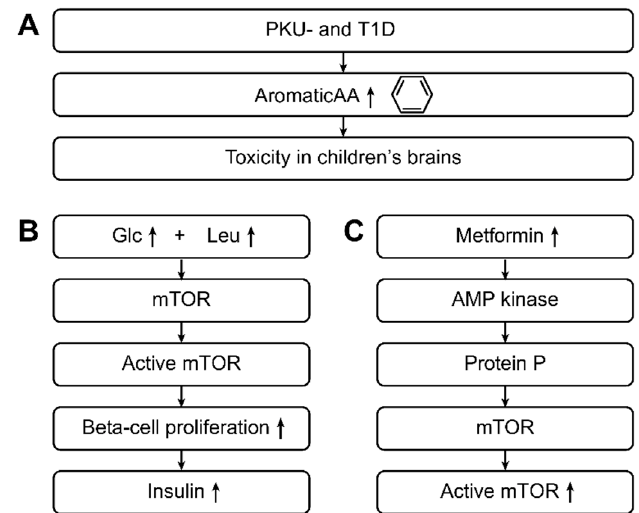
Figure 4. This figure shows the pathophysiological aspects associated with the metabolic changes in type 1 and type 2 diabetic patients. Aromatic amino acids (ArAAs) are toxic to children’s brains, and this toxicity can be observed in PKU- and T1D-positive children [72]. An important pathophysiological pathway is the following: High glucose and high leucine levels lead to the activation of rapamycin (mTOR), and activated mTOR leads to beta cell proliferation and a greater release of insulin [72]. The previous pathway can also be induced by metformin. Specifically, through AMP-kinase and subsequent protein-P activation, metformin leads to mTOR activation, leading to increased insulin levels. Through this pathway, metformin acts as a mild drug in type 2